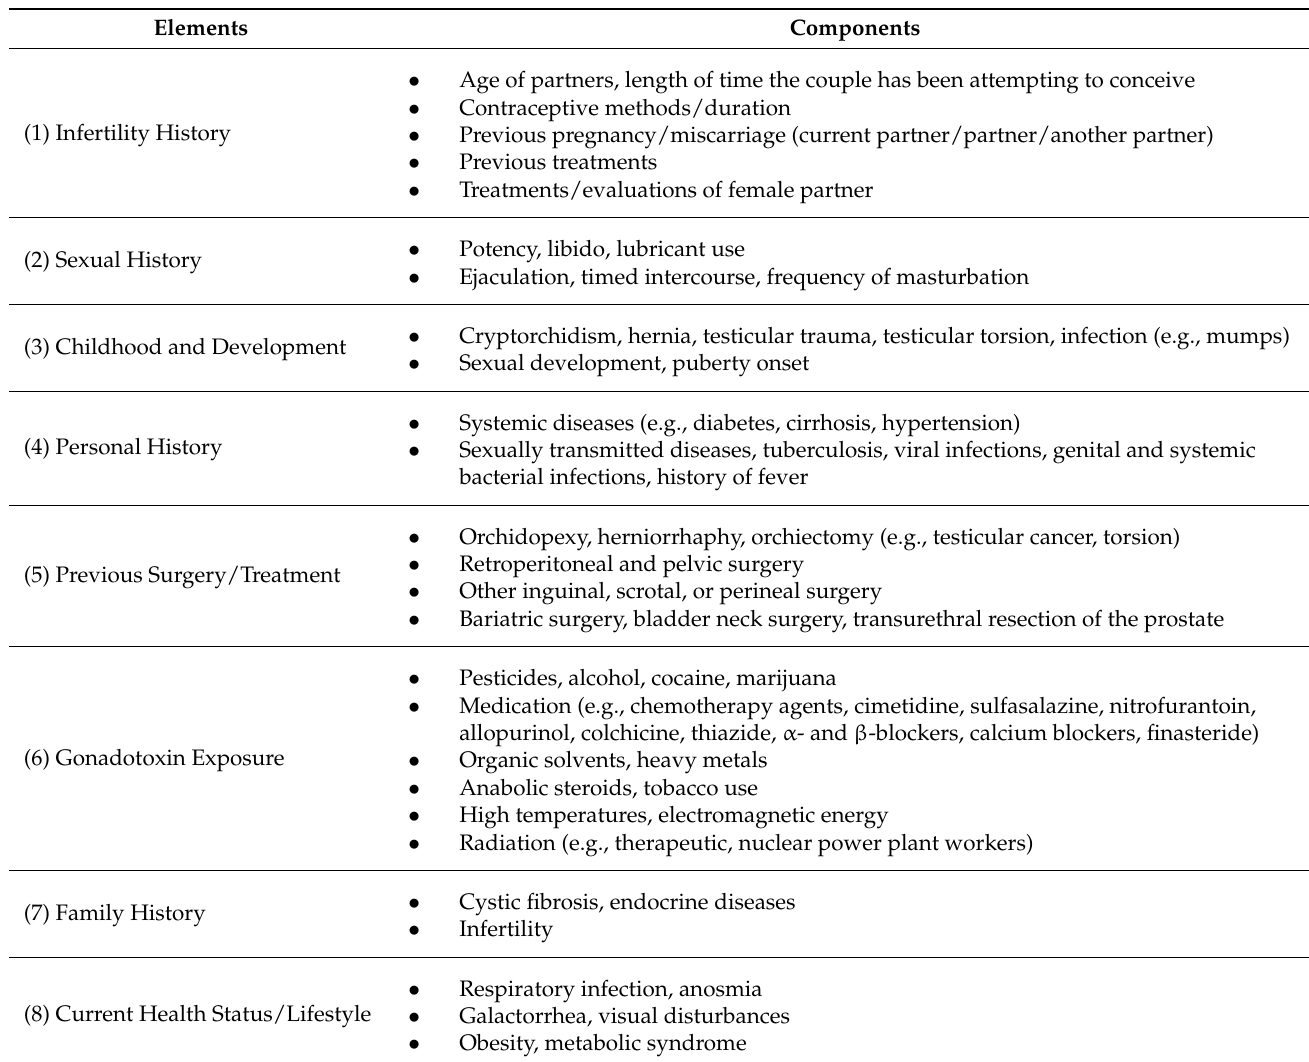
Table 1. Medical history outline. Adapted from Esteves et al. [11], Clinics 66, 691–700, 2011.